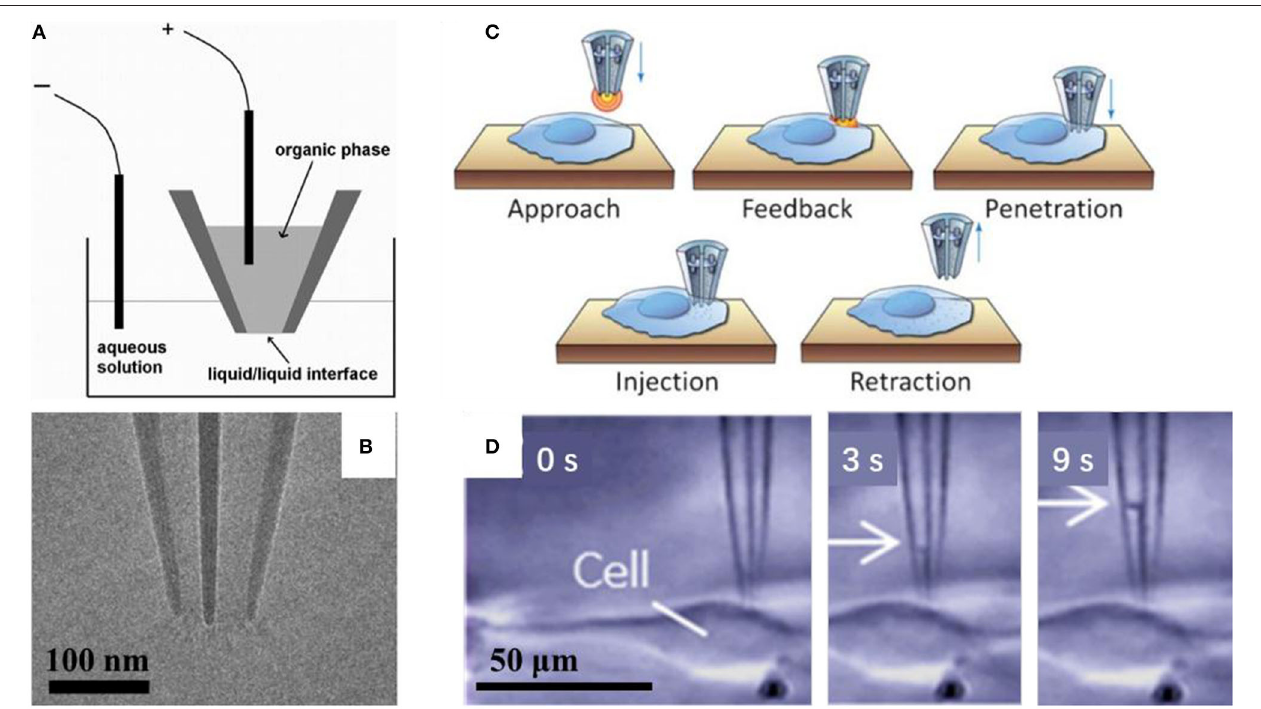
FIGURE 3 | Scheme of the electrochemical attosyringe (A) ; TEM image (B) and illustration of cell surface detection, penetration and injection (C) , and sequential micrographs acquired during cytosol collection (D) using a double-barrel